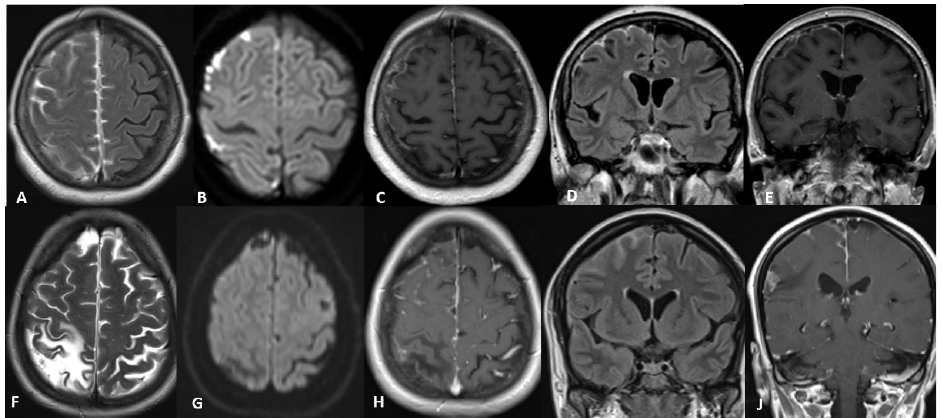
Figure 1. Case 1, ( A – E ): axial ( A ) and coronal ( D ) Fluid Attenuated Inversion Recovery (FLAIR) images show hyperintensities within the sulci without edema and mass effect in the fronto-parietal region and in the interhemispheric fissure. Axial ( C ) and Coronal ( E ) T1-weighted images with gadolinium show leptomeningeal enhancement. Note in diffusion-weighted image ( B ) abnormal diffusivity within the sulci. Case 2, ( F – J ): axial ( F ) T2-weighted image shows a fronto-parietal poroencephalic lesion on the right side due to venous thrombosis that occurred 10 years earlier. Coronal ( I ) FLAIR image demonstrates leptomeningeal hyperintensities, and axial ( H ) and coronal ( J ) T1-weighted images with gadolinium show leptomeningeal enhancement on both convexities, mostly on the right side. Patient 2 axial diffusion-weighted image ( G ) does not show abnormalities after